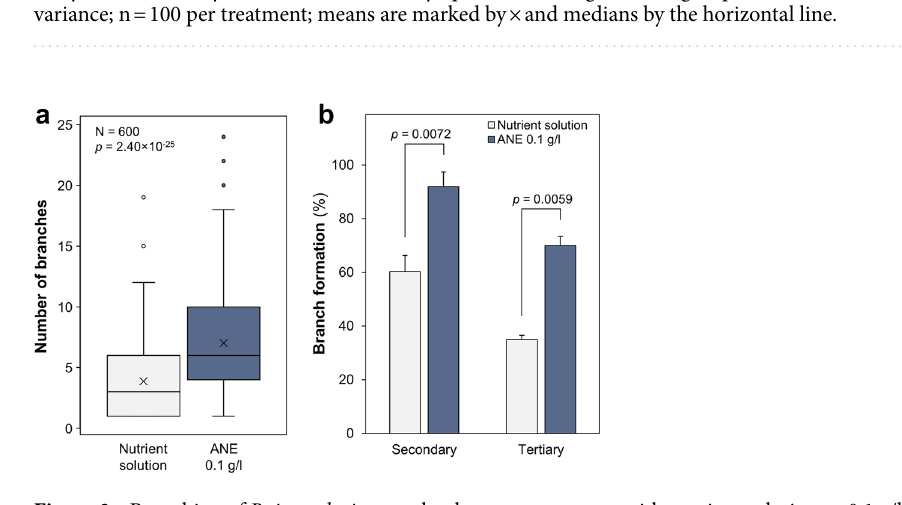
Figure 3. Branching of R. irregularis spore hyphae grown on agar with nutrient solution or 0.1 g/l ANE. Number of branches per spore ( a ) and the secondary and tertiary branch formation as a percentage of total spores ( b ) are shown. Per treatment, 300 germinated spores were assessed 4 days after spores were placed in the petri dishes. Means are marked by × and medians by the horizontal line in ( a ); indicated p values are from t tests, α =